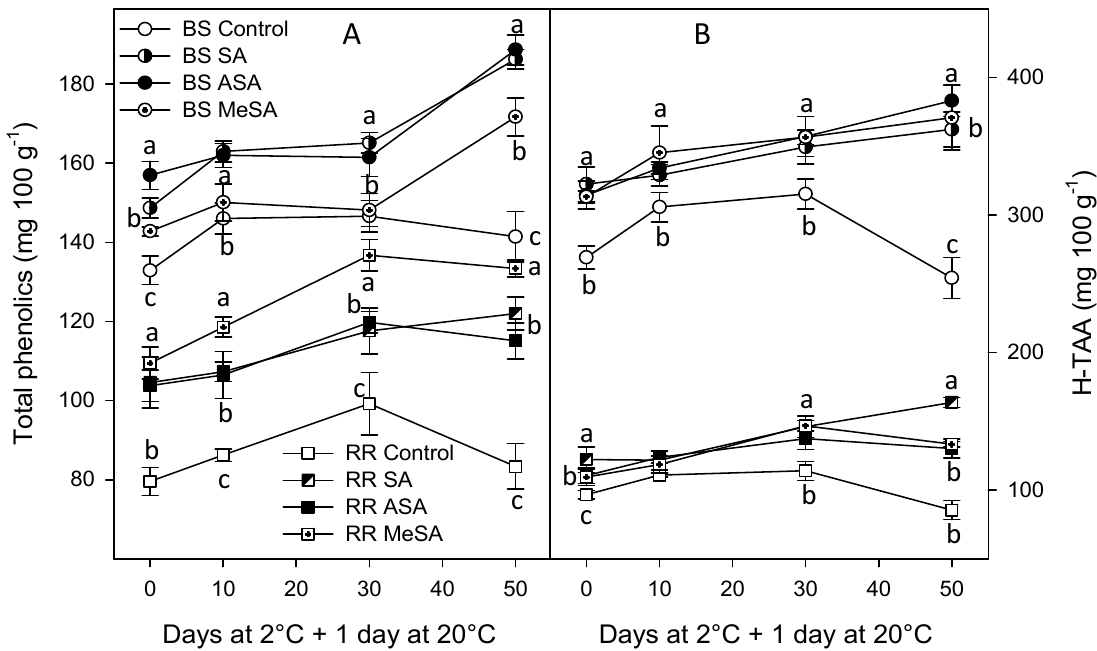
Figure 1. Total phenolic concentration ( A ) and hydrophilic antioxidant activity (H-TAA); ( B ) in “Black Splendor” (BS) and “Royal Rosa” (RR) plums from control and salicylic acid (SA)-, acetyl salicylic acid (ASA)-, and methyl salicylic acid (MeSA)-treated trees at harvest and during storage at 2 ◦ C + 1 day at 20 ◦ C. Symbols for BS and RR control and treated plums are similar for figures A and B. Data are the mean ± SE of three replicates. Different lowercase letters show significant differences ( p < 0.05) among treatments for each sampling date and cultivar.